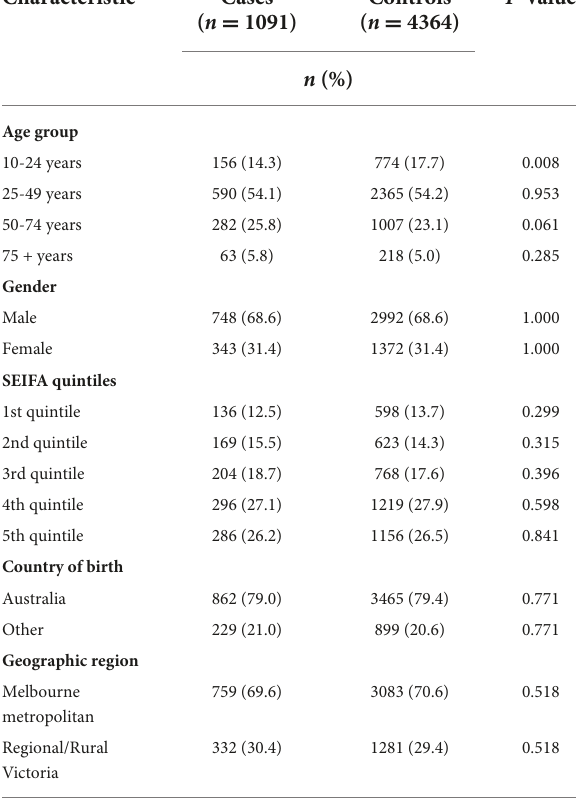
TABLE 2 Demographic characteristics of cases and